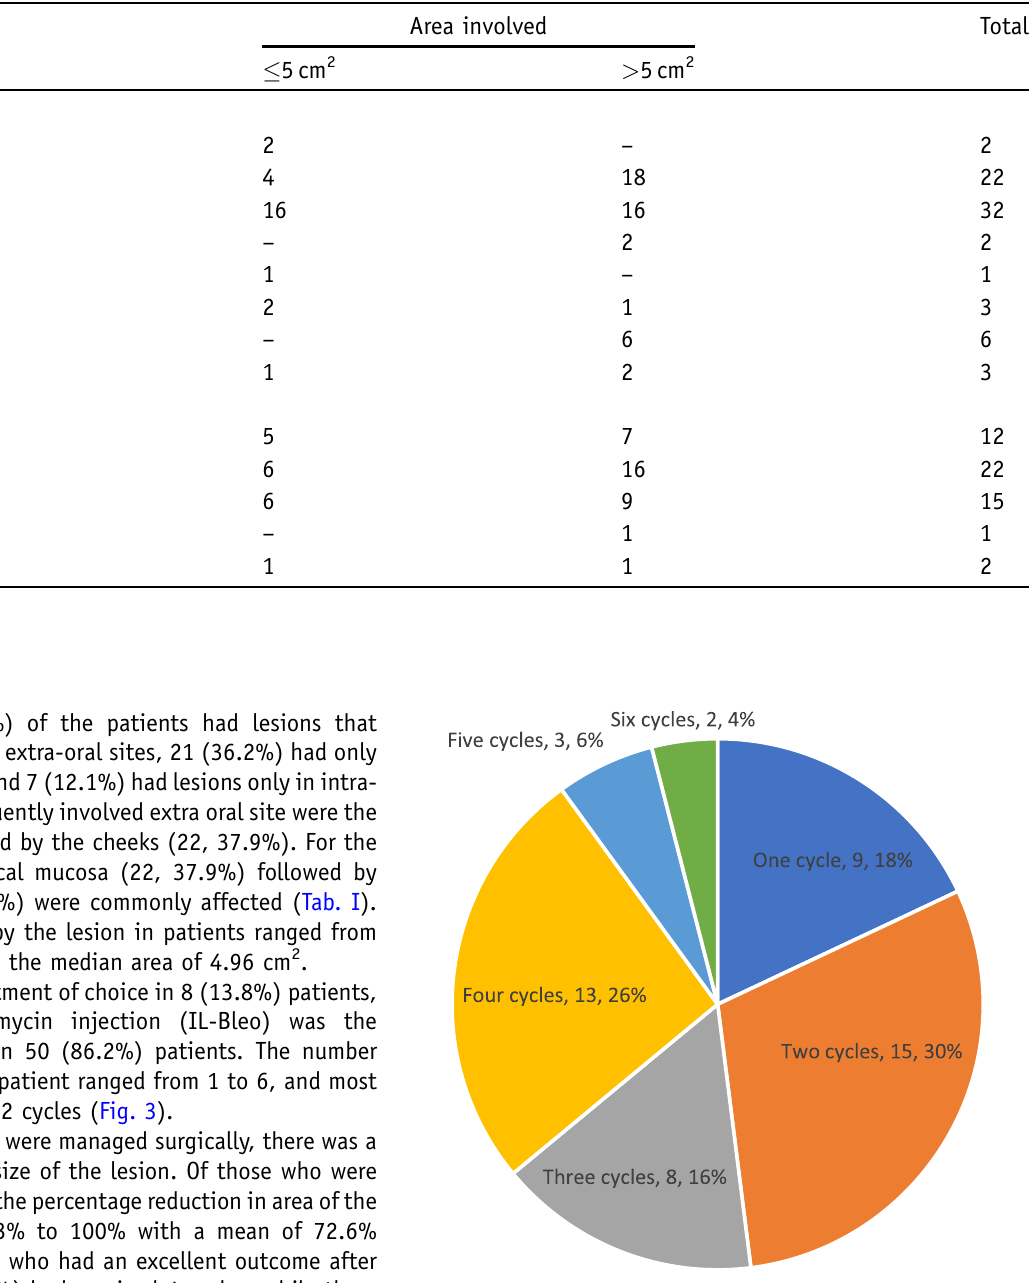
Fig. 3. Distribution of patients according to the number of cycles of intralesional bleomycin injection they